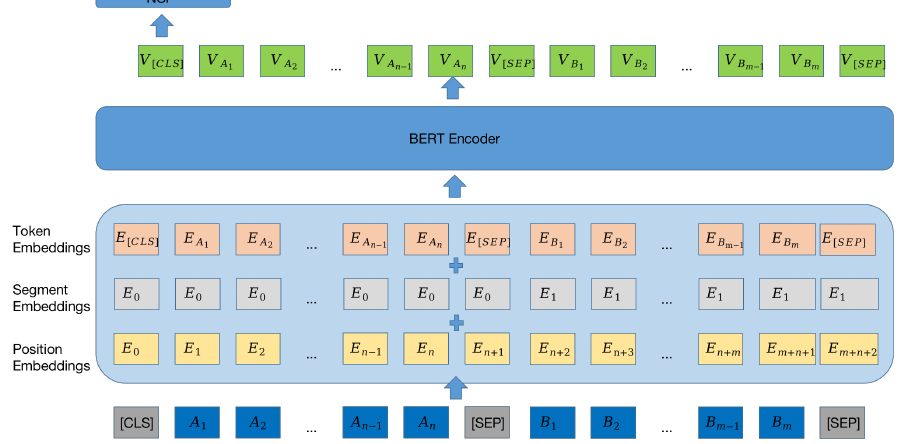
Figure 3. The framework of text-only NSP pre-training. It is exactly the same as the general BERT structure for